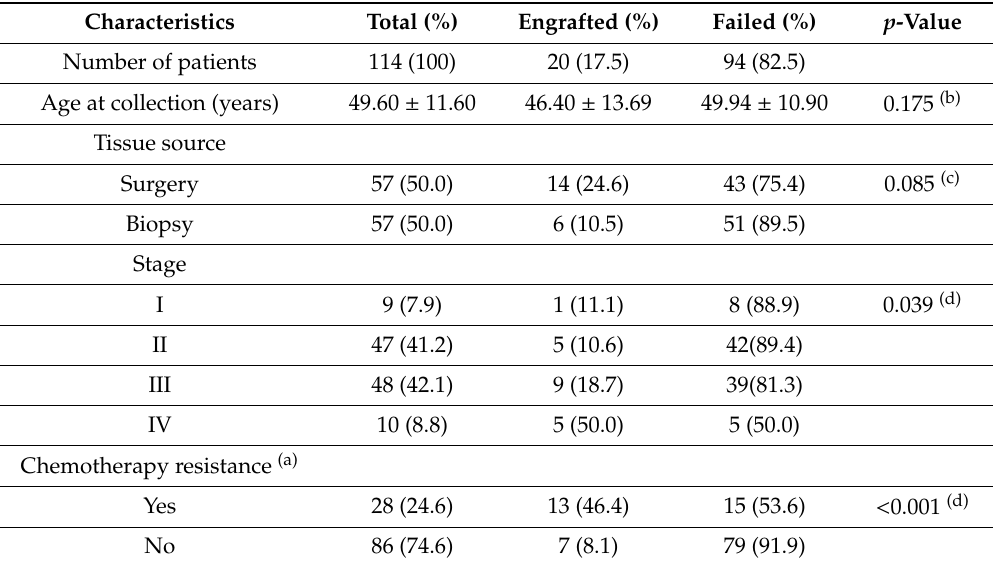
Table 1. Clinical characteristics of patients according to engraftment